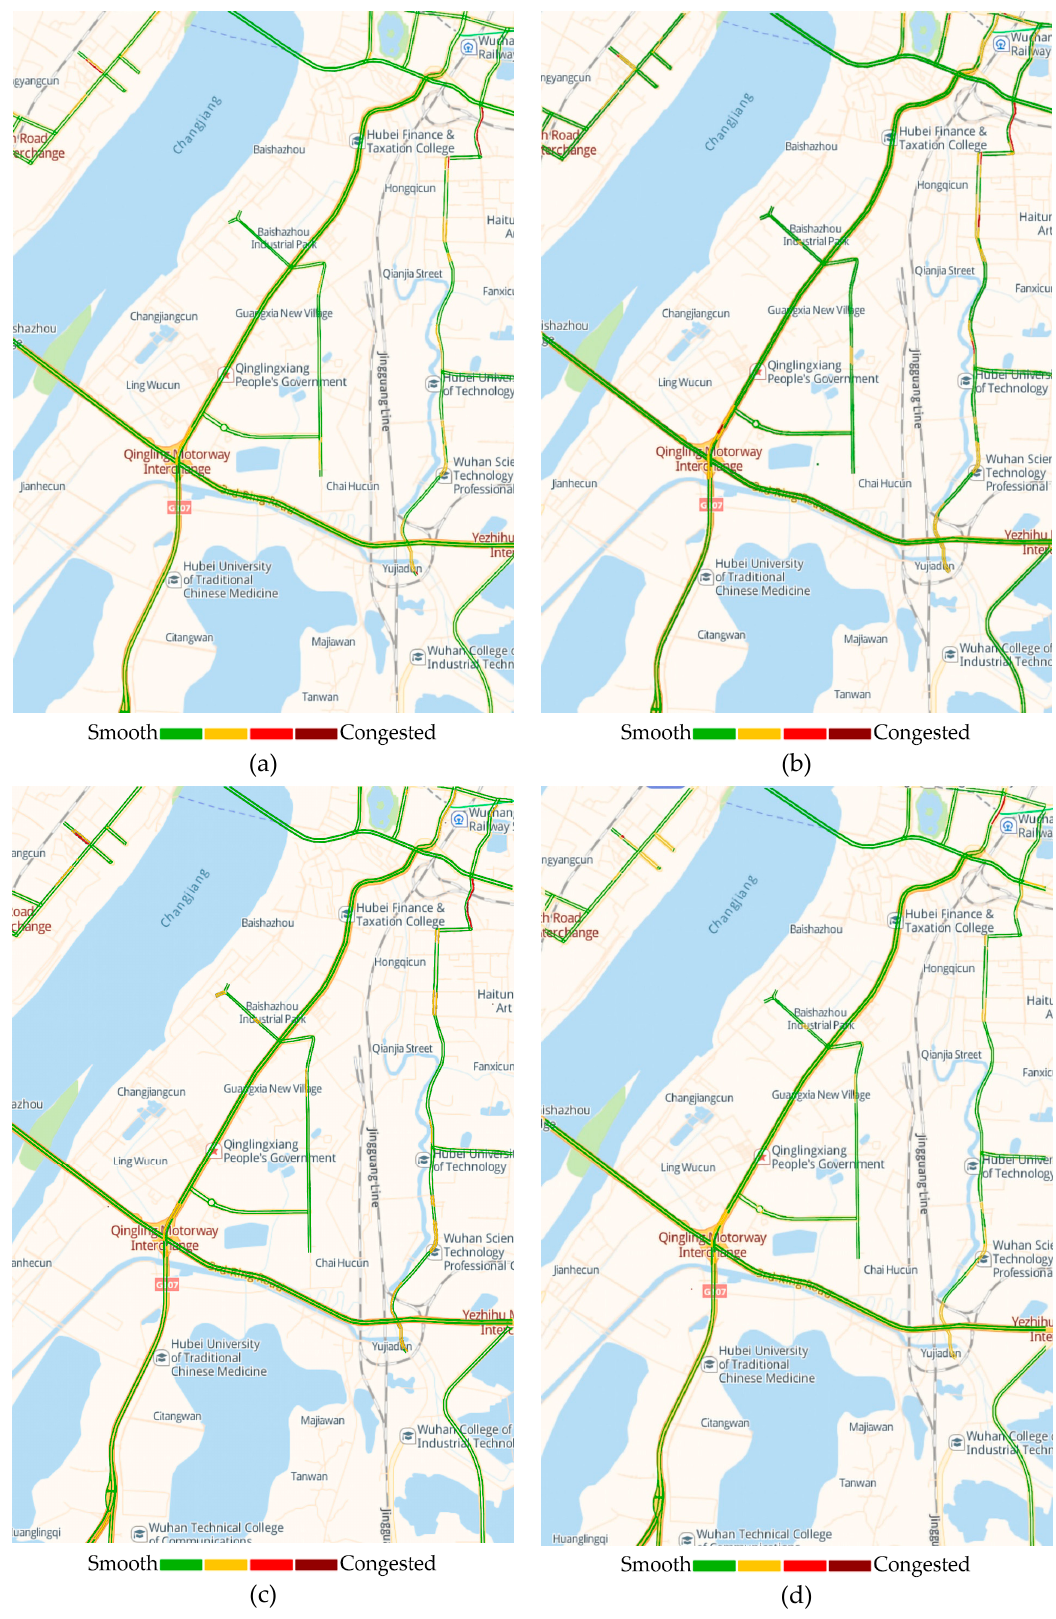
Figure 8. Traffic forecasts for the four studied hours based on the big data from Gaode Map. ( a ) 7:00 Figure8. Tra ffi cforecastsforthefourstudiedhoursbasedonthebigdatafromGaodeMap. ( a )7:00tra ffi c traffic conditions; ( b ) 8:00 traffic conditions; ( c ) 9:00 traffic conditions; ( d ) 10:00 traffic conditions. conditions; ( b ) 8:00 tra ffi c conditions; ( c ) 9:00 tra ffi c conditions; ( d ) 10:00 tra ffi c Since Gaode’s data is only accurate to the hour and cannot be matched with the temporal granularity of traffic conditions in this simulation, comparisons can only be made on a similar time